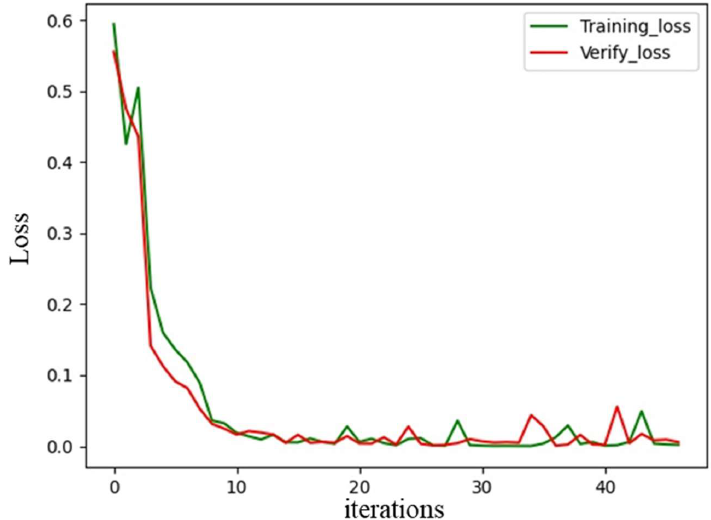
Figure 6. Loss curve of the path number discrimination model.